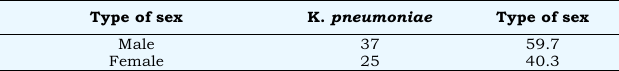
Sixty tow isolates were belonging to K. pneumoniae positively from respiratory tract infections, 37(59.7%) of them were males and 25(40 .3%) female (Table 3). Table 3 Distribution of K. pneumoniae isolates among both sex Type of